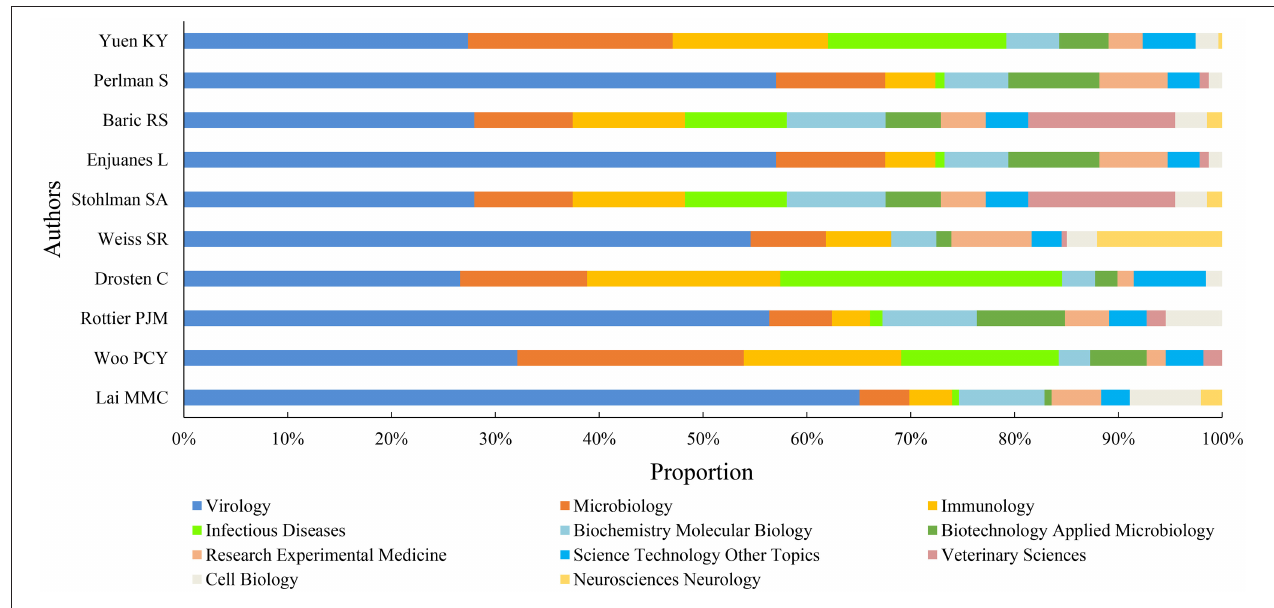
FIGURE 5 | Proportion of top-5 research areas for the top-10